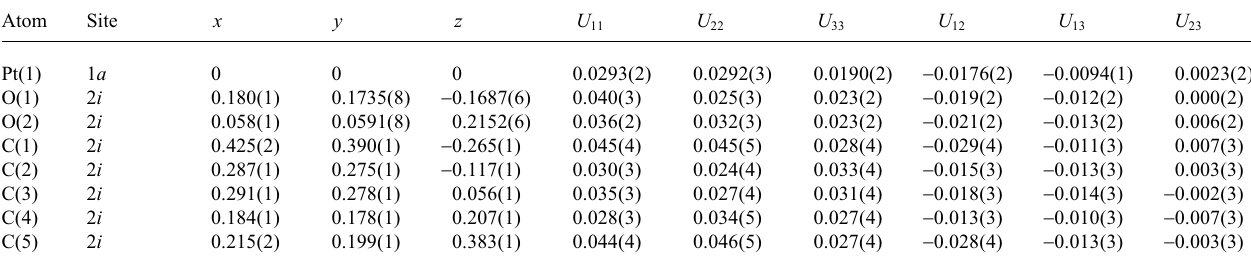
Table 3. Atomic coordinates and displacement parameters (in Å 2 ) .